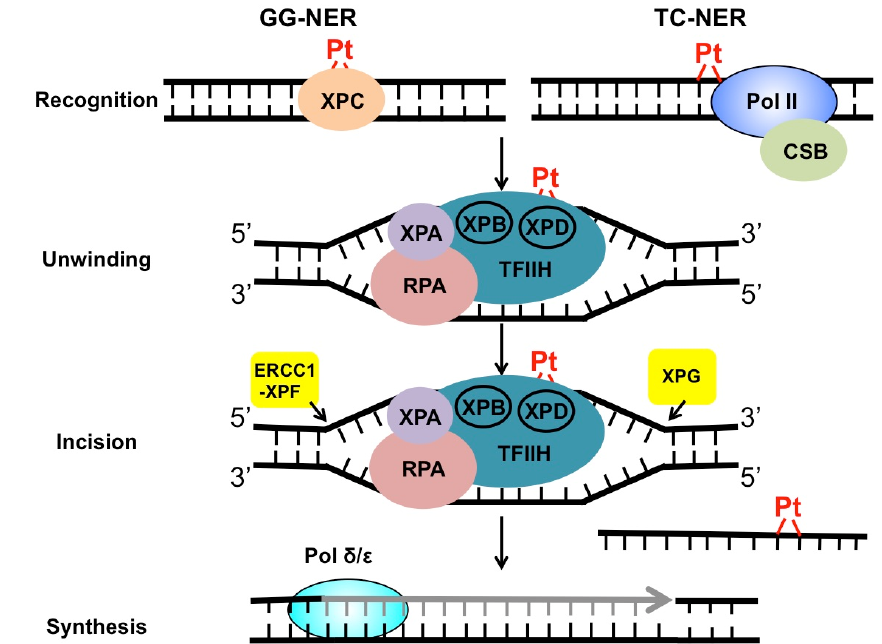
Figure 2. Repair of cisplatin-induced DNA damage by NER. Cisplatin damage can be recognized by surveillance protein XPC or elongating RNA Pol II, to initiate GG-NER or TC-NER. After damage recognition, the two subpathways utilize the same set of repair enzymes to conduct DNA unwinding, dual incision, and repair synthesis and ligation.